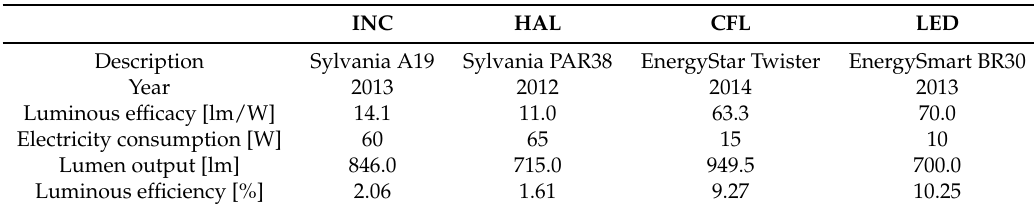
Table 3. Metadata for example lamps, including year the SPD data were obtained, luminous efficacy, electricity consumption rate, lumen output, and luminous efficiency